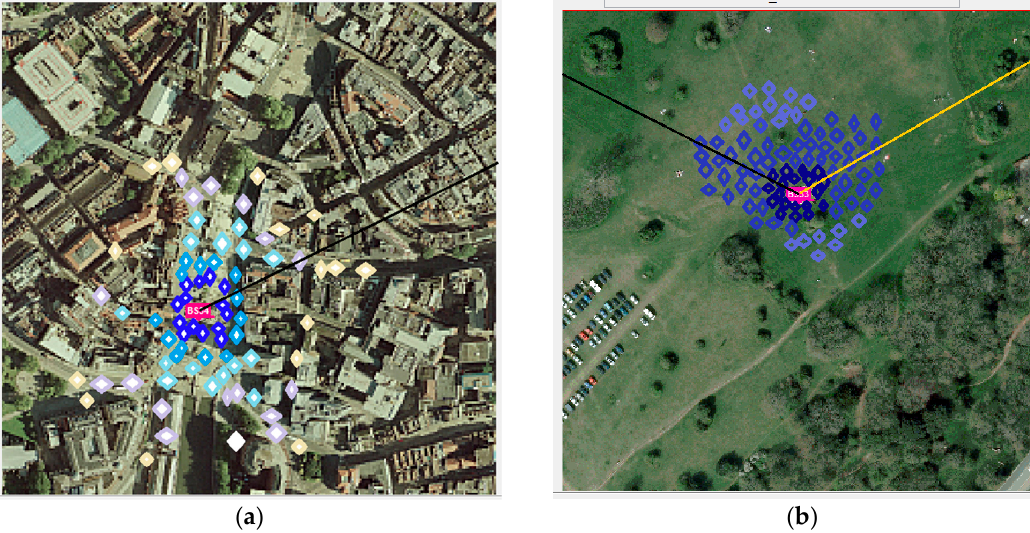
Figure 6. ( a ) Dense urban area/city center (sampled color-coded positions: same color means positions with same received signal power). ( b ) Park/farmland, showing trees and open areas [3].